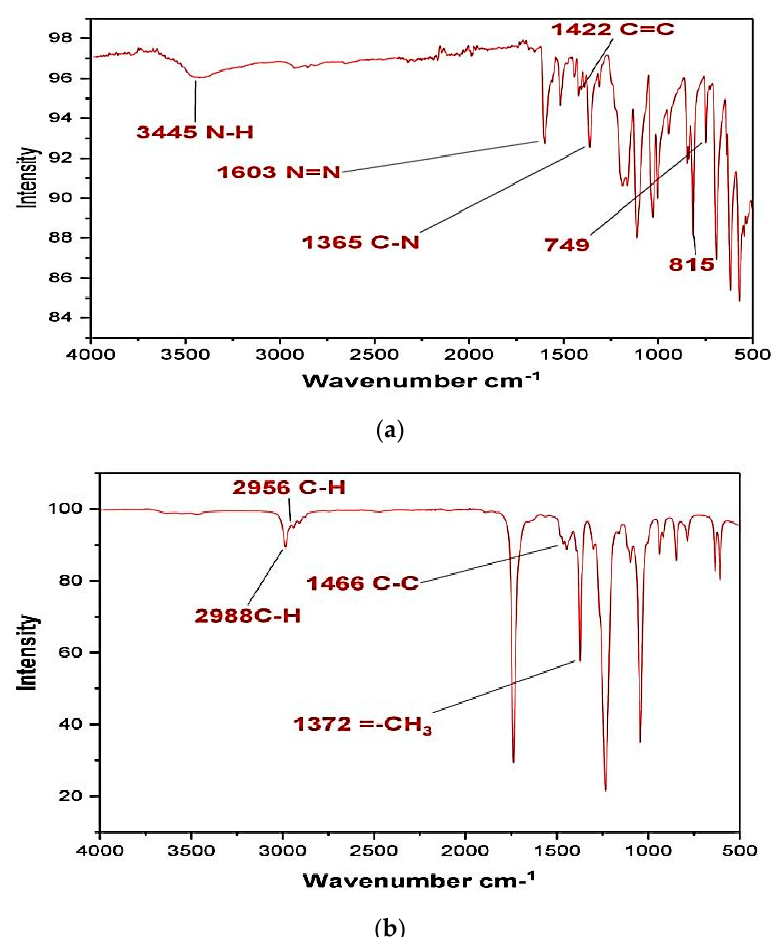
Figure 9. ( a ) Methyl orange original dye FTIR. ( b ) Methyl orange dye FTIR after Pseudomonas aeruginosa degradation.